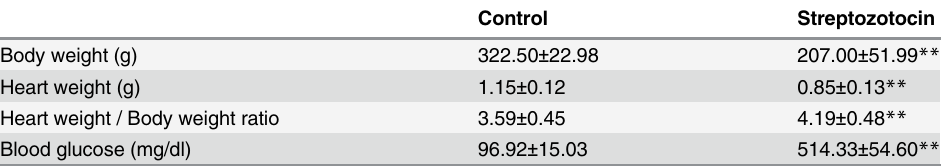
Table 2. General characteristics of streptozotocin-induced diabetic